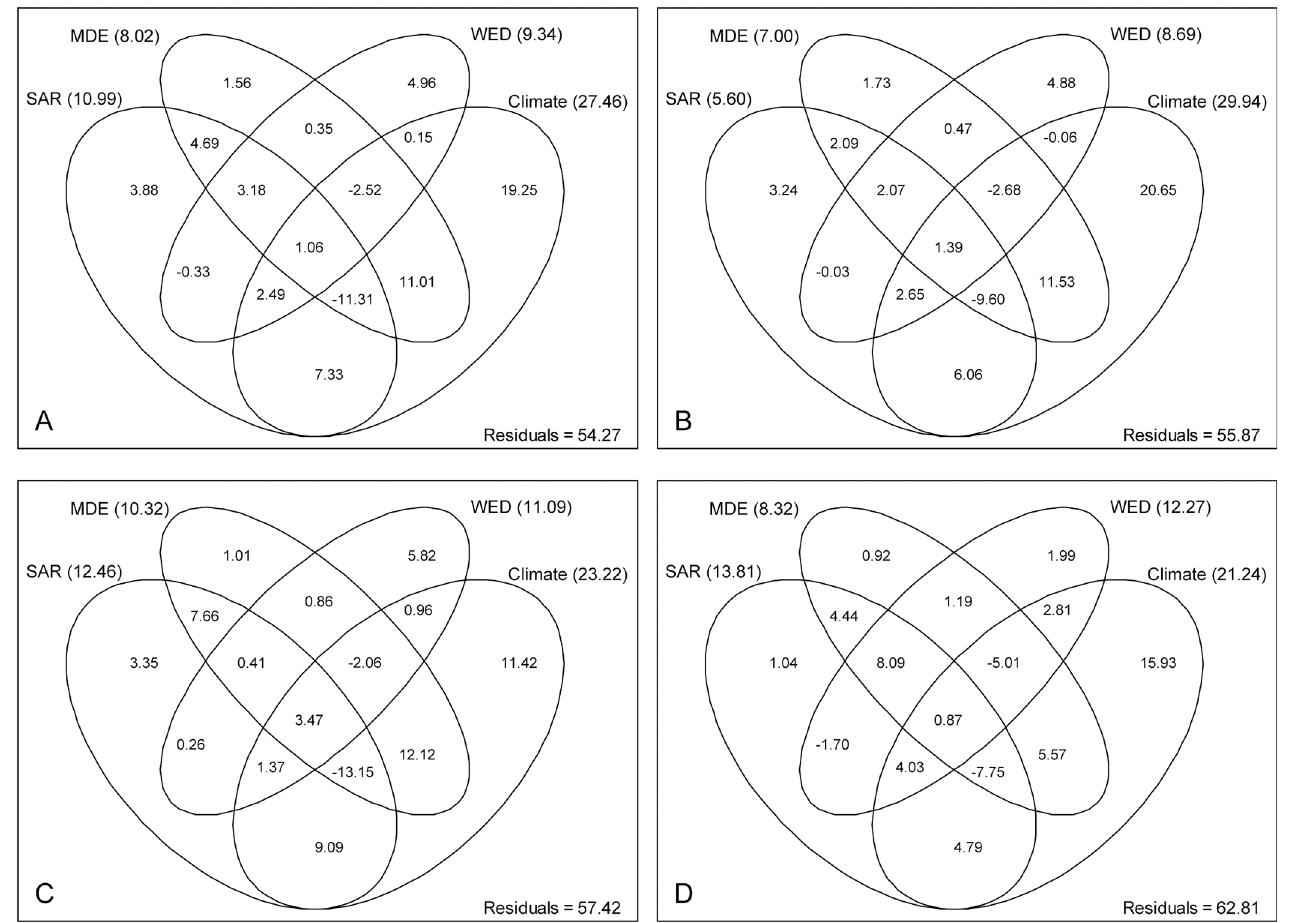
Fig 5. Partitioning of species richness into species-area relationship (SAR), mid-domain effect (MDE), water-energy dynamics (WED) and climate components all orchid species (A), and for epiphyte (B), terrestrial (C), and saprophyte (D) life forms in Yunnan, China. Values in the fractions represent adjusted R 2 coefficients of the independent or shared effects of the four hypotheses. The total effect (including the independent and shared effects) of each explanatory component is shown in parentheses.